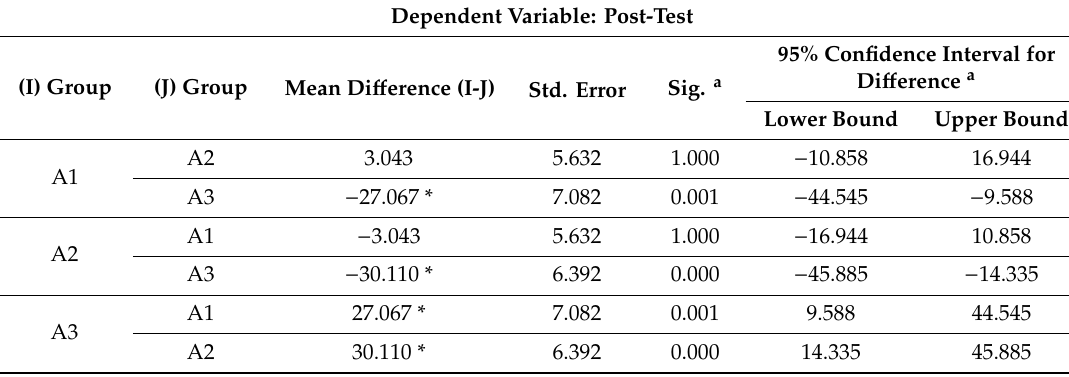
Table 5. Bonferroni Test (Pairwise